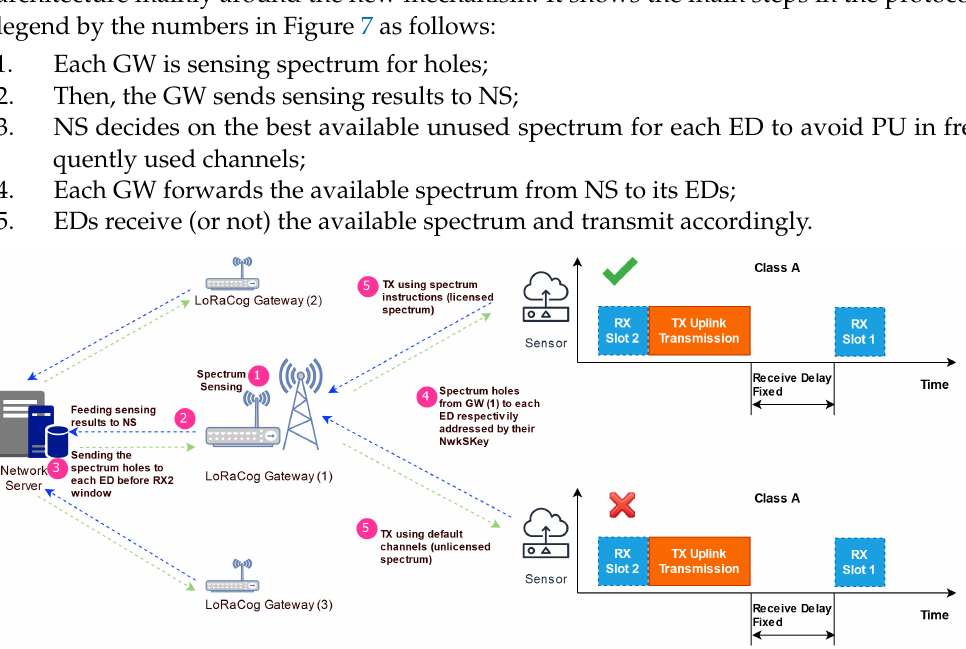
Figure 7. LoRaCog Global